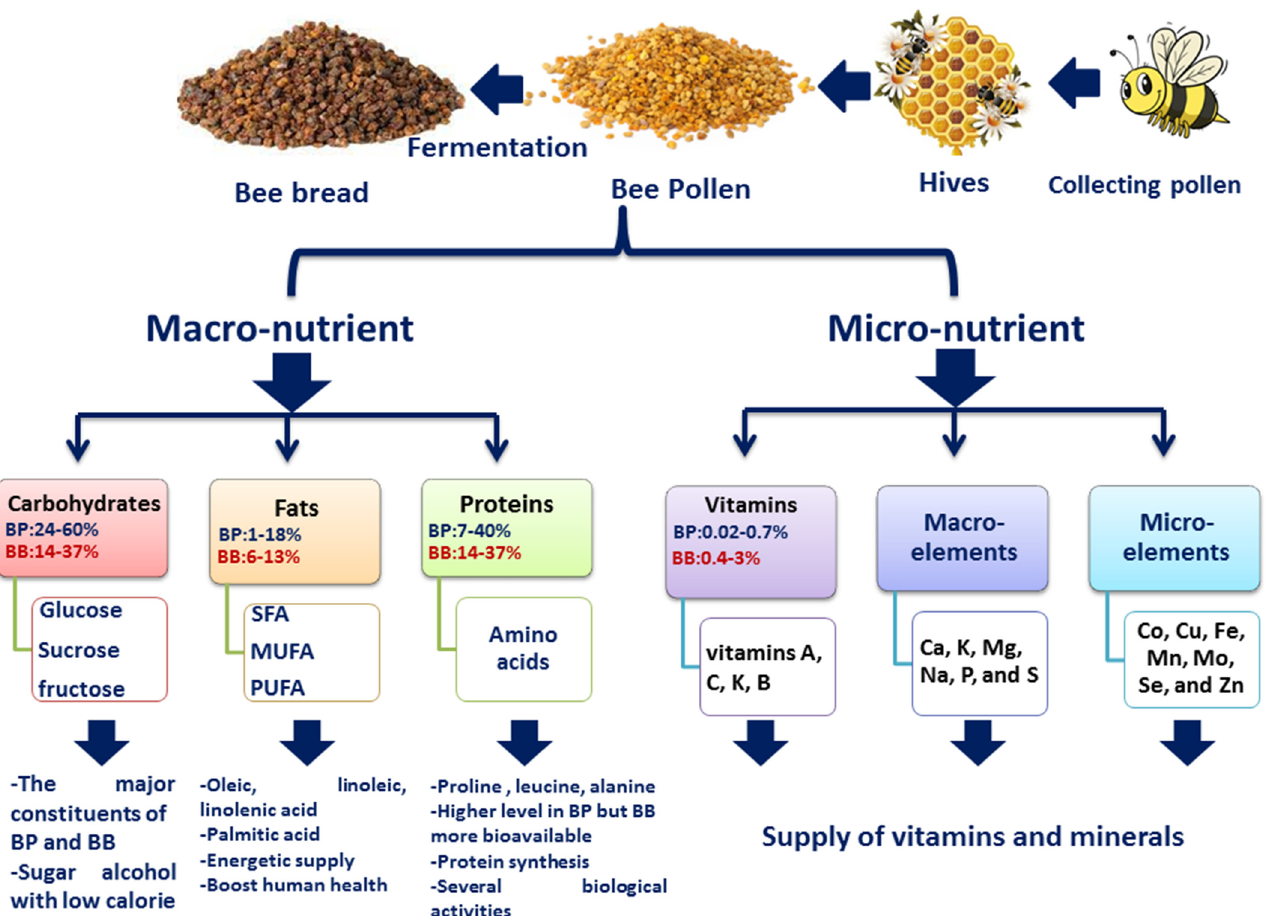
Figure 1. Schematic presentation of the collection of BP and formation of BB, and the macro- and micronutrients identified in both bee products, such as carbohydrates, fats, proteins, vitamins, macro-, and microelements.